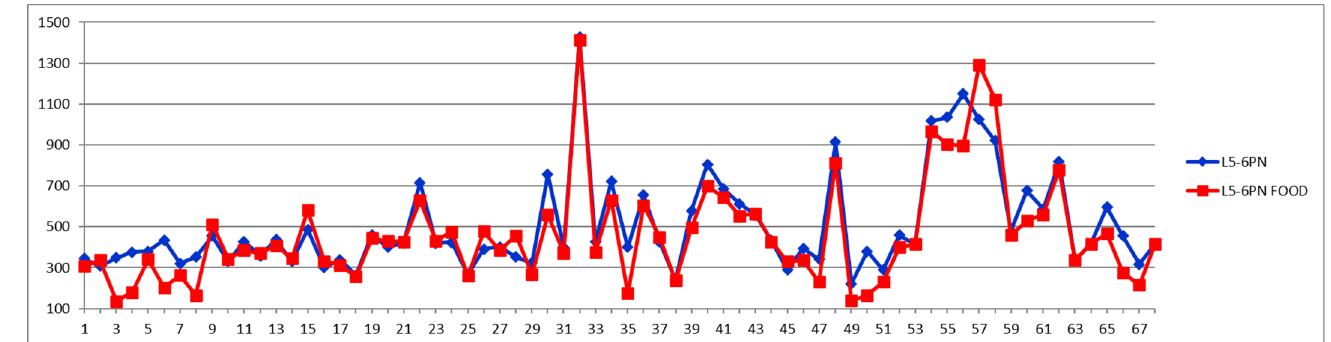
Figure 5. Small LDL particle number (L5PN+L6PN) (nmol/L) in fasting (blue) and postprandial (red) status for control cases (1–29) and CVD cases (30–68).